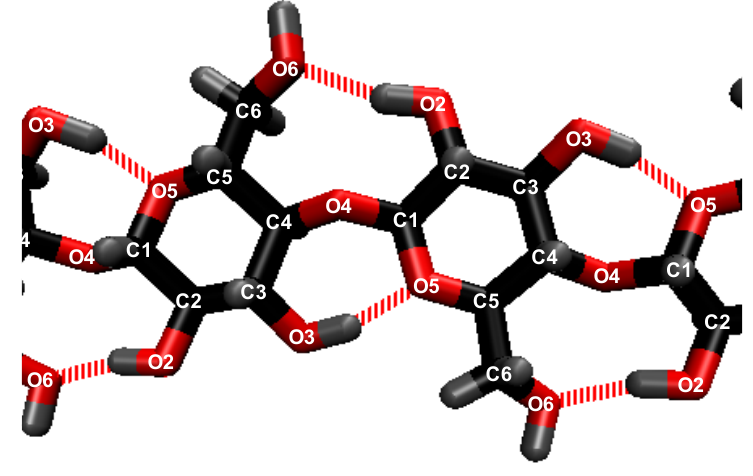
Figure 2. Atomic labeling for the cellulose strands. The black, red, and gray atoms are carbons, oxygens, and hydrogens, respectively. The dashed lines are hydrogen bonding within the cellulose strand or intra-strand hydrogen bonding. For clarity, only the carbons and the oxygens are labeled in the cellulose strands. In the cellulose strands: the hydrogens bonded to the oxygens are named HO2, HO3, and HO6, corresponding to the O2, O3, and O6 oxygens, respectively; the hydrogens bonded to the carbons are named H1, H2, H3, H4, H61, and H62, corresponding to the C1, C2, C3, C4, C6, and C6 carbons, respectively